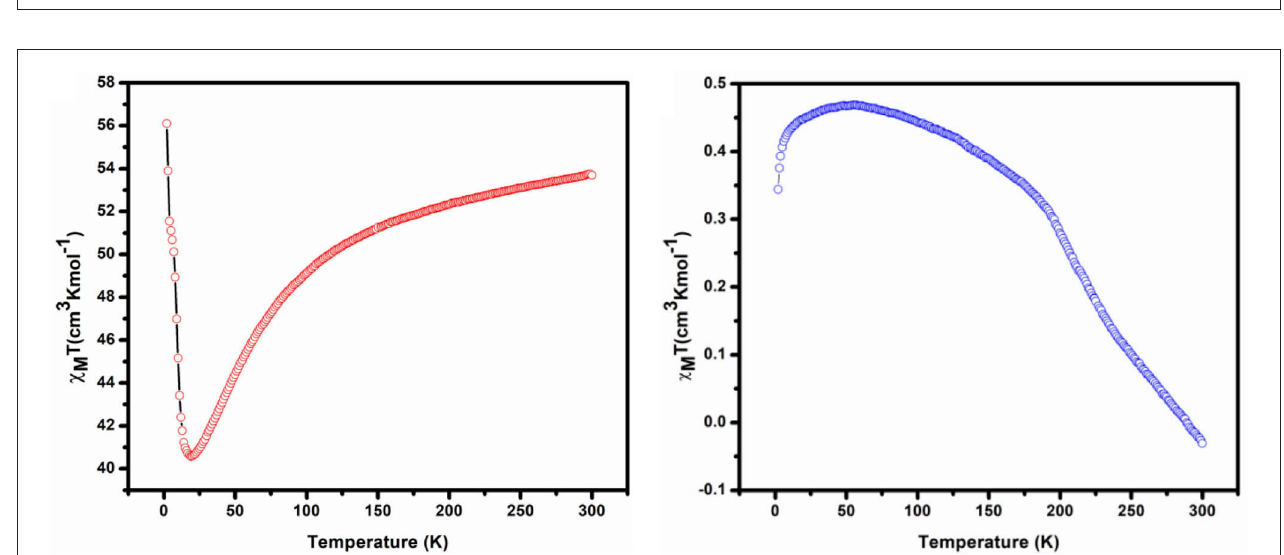
FIGURE 6 | DC magnetic susceptibility plot of χ M T vs. T for complex 1 (Left) 2 (Right)